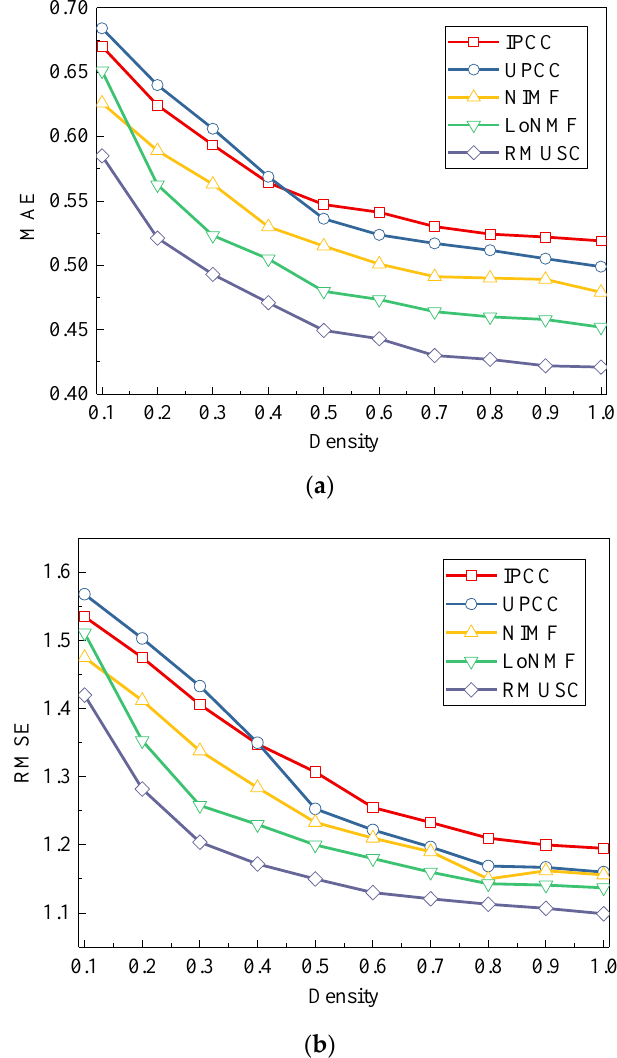
Figure 8. Comparison results of service recommendation algorithms. ( a ) Results of mean absolute error; ( b ) Results of root mean square error.